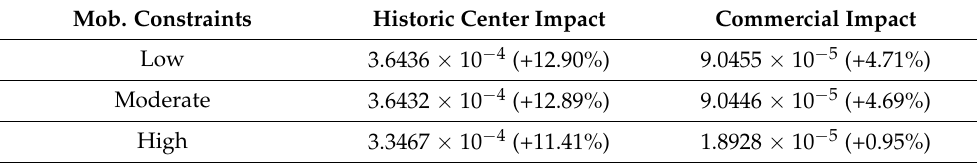
Table 10. Comparison of the average of the APA centrality of main streets of the city in terms of accessibility before and after the restoration of the selected three